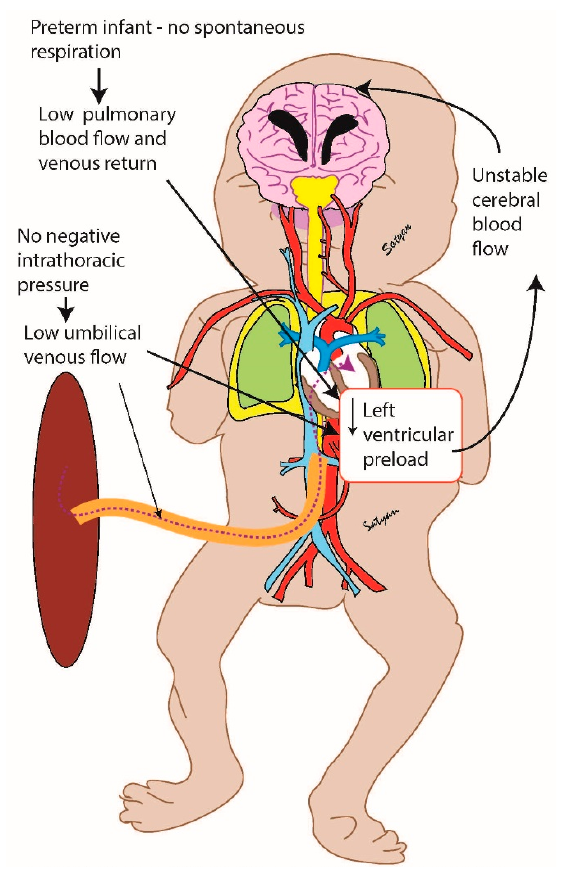
Figure 1. Preterm infant without spontaneous respirations.